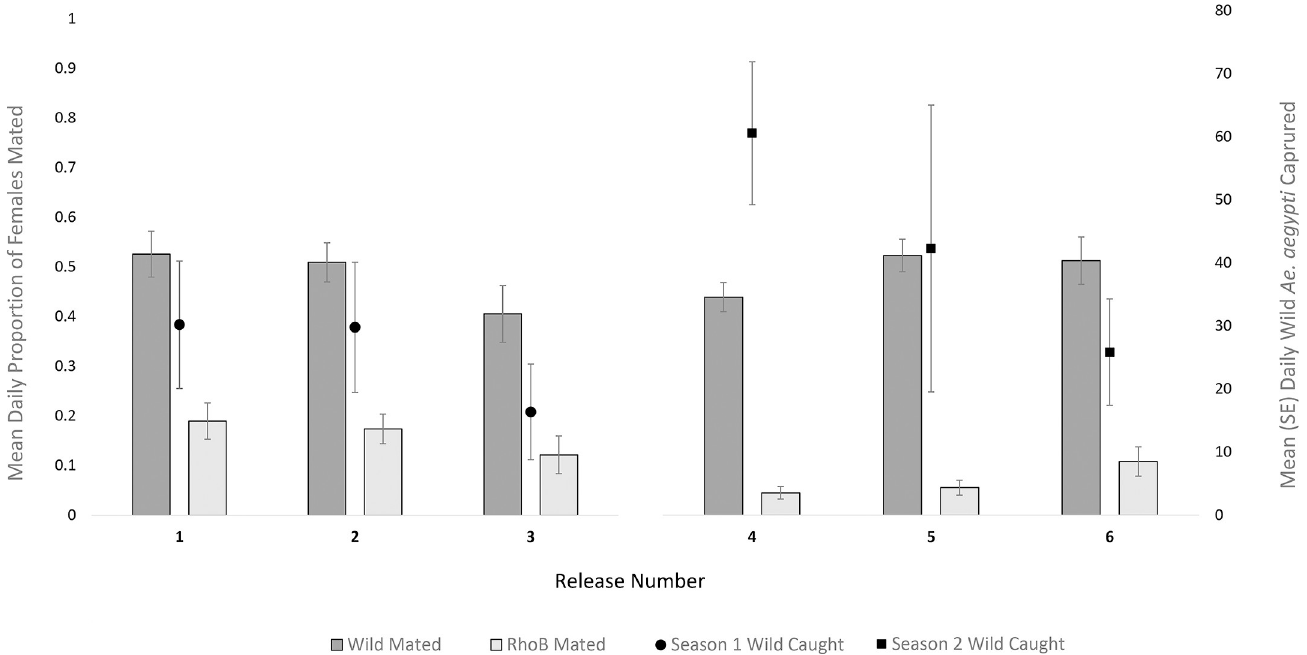
Fig 4. A comparison of mating rate with wild Ae . aegypti captured during six mark-release-recapture experiments in Innisfail, Australia. Primary axis indicates the mean daily proportion ( ± SE) of wild and rhodamine B inseminated female Ae . aegypti . Second axis indicates the mean daily total (male and female) number ( ± SD) of wild male and female Ae . aegypti captured during each experiment.